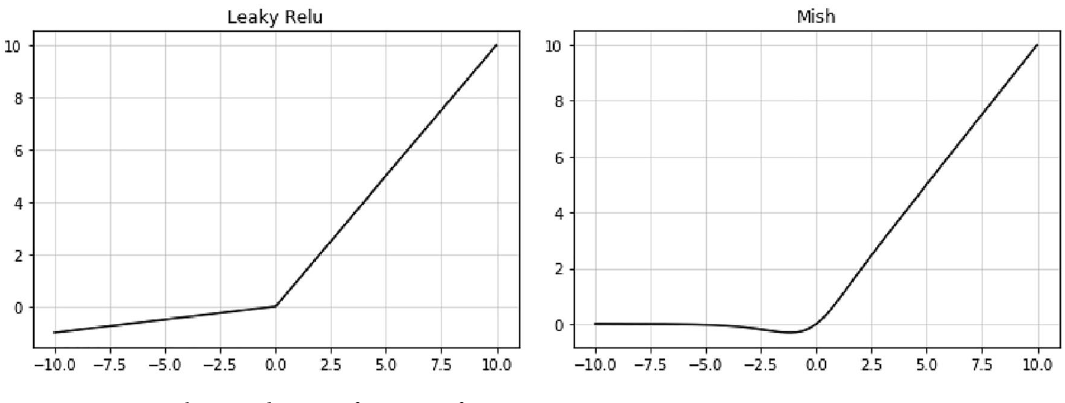
Figure 4. Schematic diagram of activation